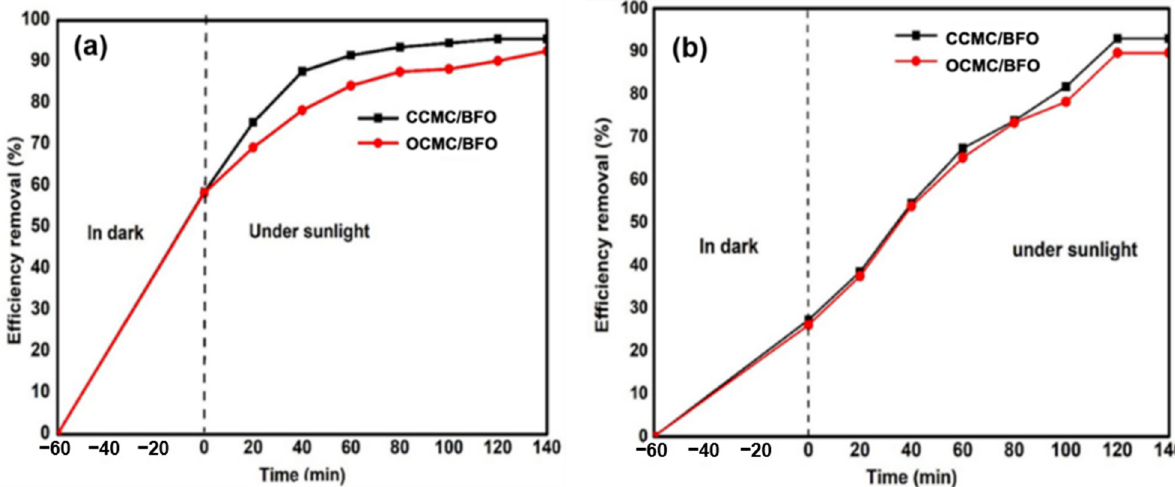
Figure 9. Efficiency removal of nanocomposite film CMC/BFO and CMC OPEFB /BFO after a 3-h treatment, ( a ) CR, ( b ) MO.